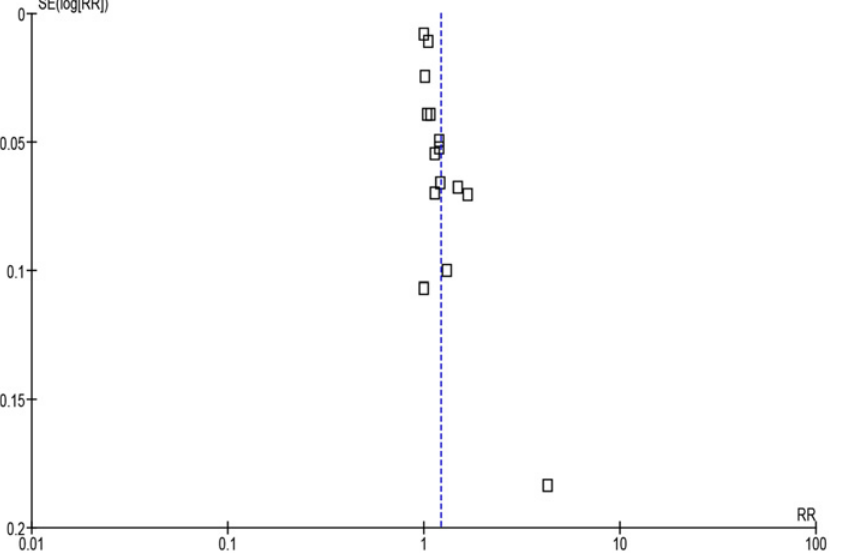
Figure 2. Forest plot depicting the risk ratios (RR) of compliance of patients receiving antibiotic treatment once-daily versus multiple times daily. (Vertical line = “ no difference ” point between the two regimens. Squares = risk ratios; Diamonds = pooled risk ratios for all studies. Horizontal lines = 95% CI) .